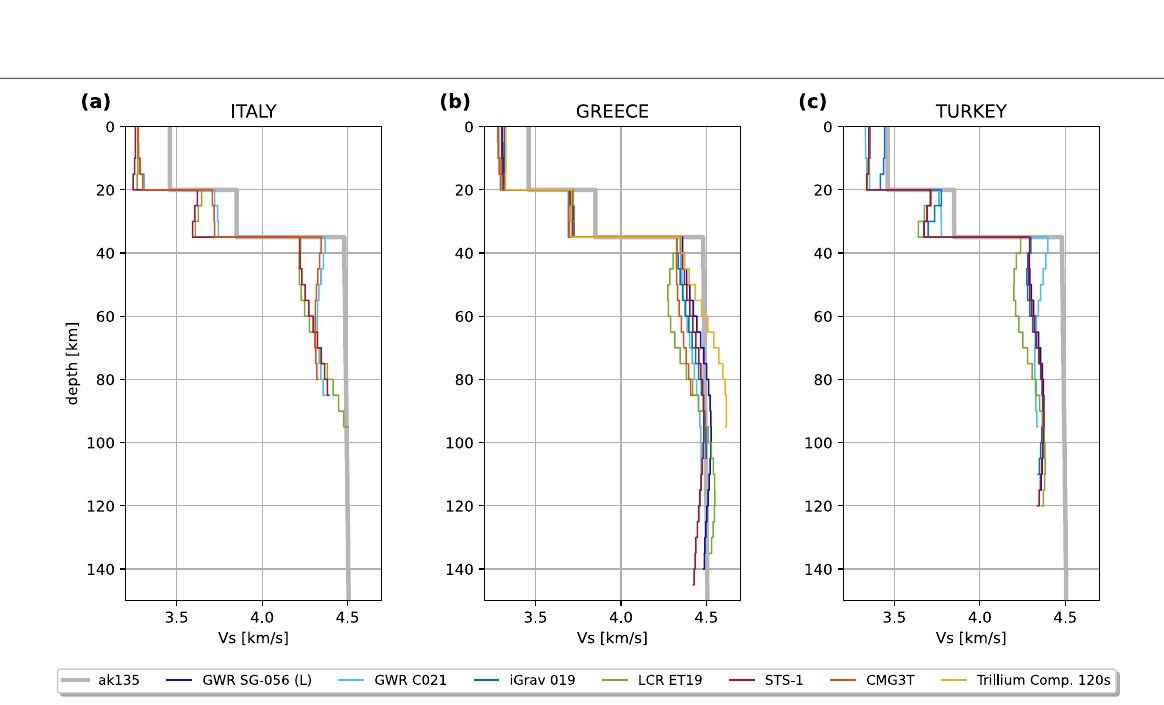
Fig. 10 Averaged distribution of S‑wave velocity ( V s ) with depths between instruments and earthquakes’ epicentres from the Italy, Greece and Western Turkey regions